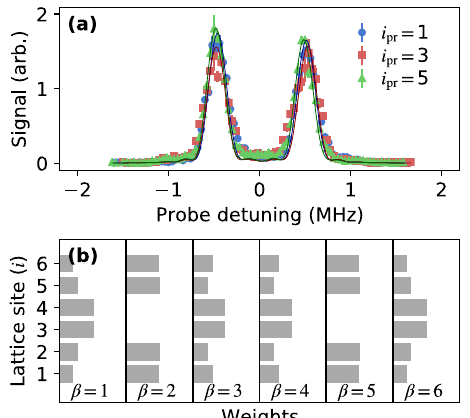
Fig. 5 Detection of edge and bulk states by selective fi eld ionization (SFI). SFI signals for probe laser tuned near the 58 s Rydberg level ( i pr = 3) for J s / J w = 5 [Fig. 2a]. Vertical lines indicate ionization fi elds for bare Rydberg levels. Data points are evenly spaced in time. ( a ) For excitation to (cid:3) ± 500 kHz), the state excited is the left and right bulk-state peaks ( Δ i pr localized on the bulk sites of the synthetic lattice. (( b ) For excitation to the (cid:3) 0) the state is localized on the 57 s ( i = 1) boundary edge-state peak, ( Δ i pr site. The small contribution to the signal at i = 2, 3, 4, and 5 is predominantly from the wings of the bulk-state